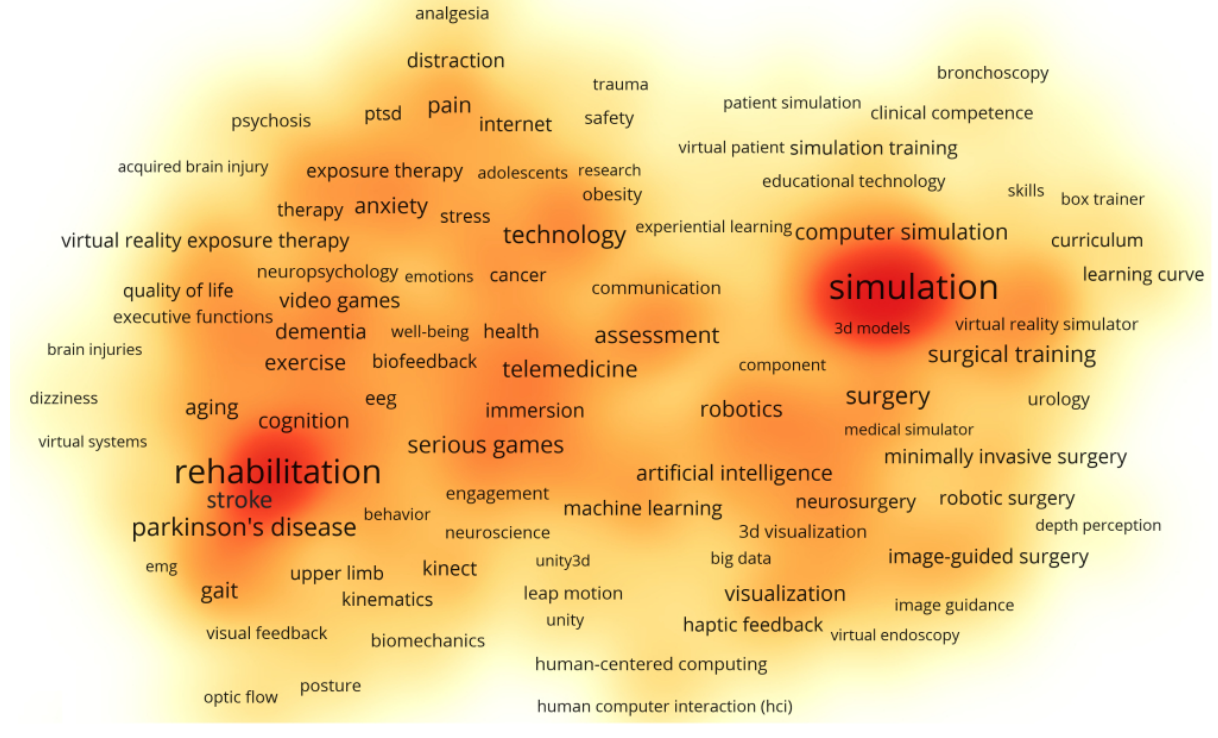
Figure 4. Density map showing author keywords of the publications in virtual reality research in medicine. Keywords occurring in at least 0.1% (9/8399) of the publications were included. The keywords “virtual reality,” “augmented reality,” and “mixed reality” are not shown as they were the major search terms. A keyword or cluster of keywords with higher frequency counts forms a red region, and those with lower frequency counts form a yellow